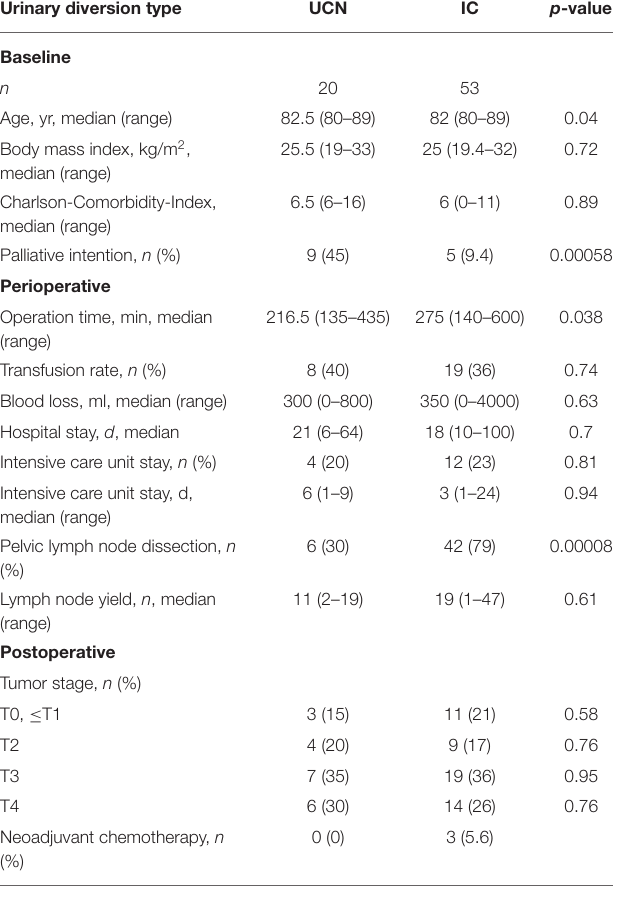
TABLE 4 | Bowel complications requiring revision.